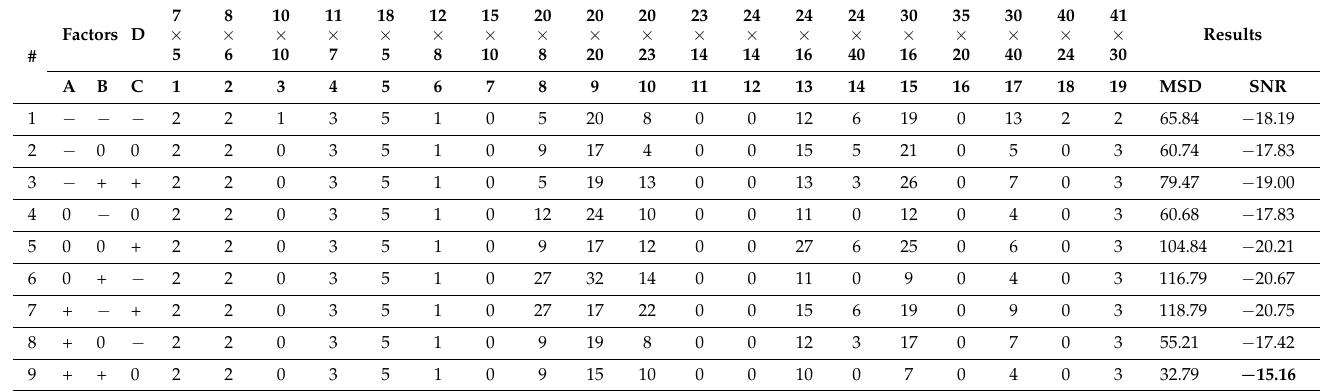
Table 3. Combination of factors and resulting values of the trials of experiments (Group